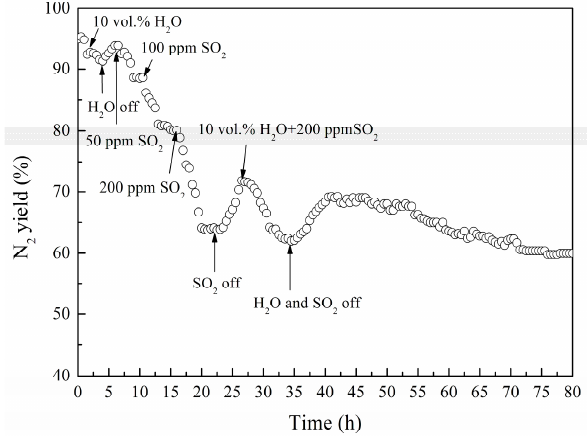
Figure 1. The stability of Co-Zn/H-Beta in C 3 H 8 -SCR under the dual effects of SO 2 and H 2 O.